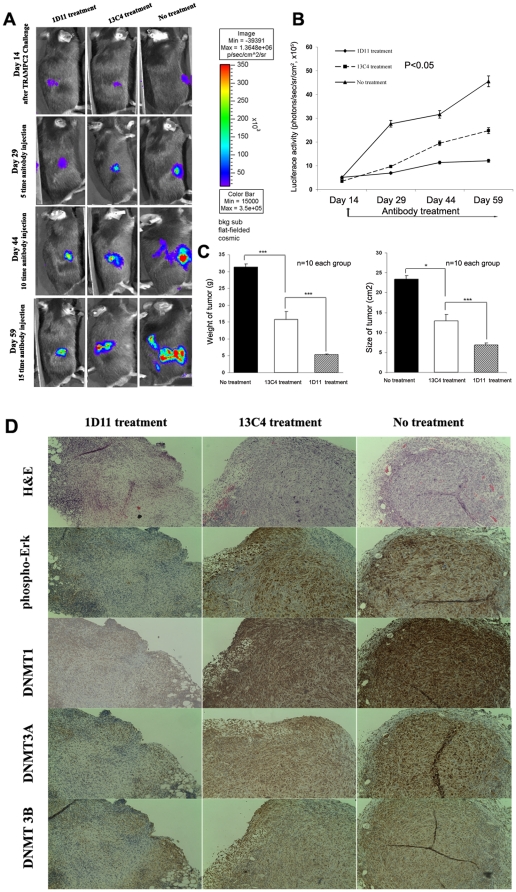
TGF-β induced DNMTs is associated with growth of prostate cancer in vivo.
A. IVIS 100 imaging system was used to monitor tumor growth in real-time. We found that tumor growth is inhibited dramatically with the treatment of 1D11 compared with Group 2 (13C4 treatment) and 3 (No treatment control). B. 1D11 treatment inhibits the tumor growth in a time dependent manner. C, At the end of the 45-day treatment period, mice were sacrificed and tumors were isolated. The average tumor weight and volume was 5.3 g and 6.85 cm3, respectively in 1D11 treatment group. In comparison, the average weight and volume of tumors in the 10 animals treated with the control 13C4 was significantly greater at 15.8 g and 12.85 cm3, respectively. The corresponding values in the mice that received no treatment were 31.4 g and 23.39 cm3, respectively (P<0.01 among three groups). D. Immunohistochemical analyses of the primary tumors revealed that the expression of p-ERK, DNMTs in animals with 1D11 treatment is significantly lower than those of the other two groups.